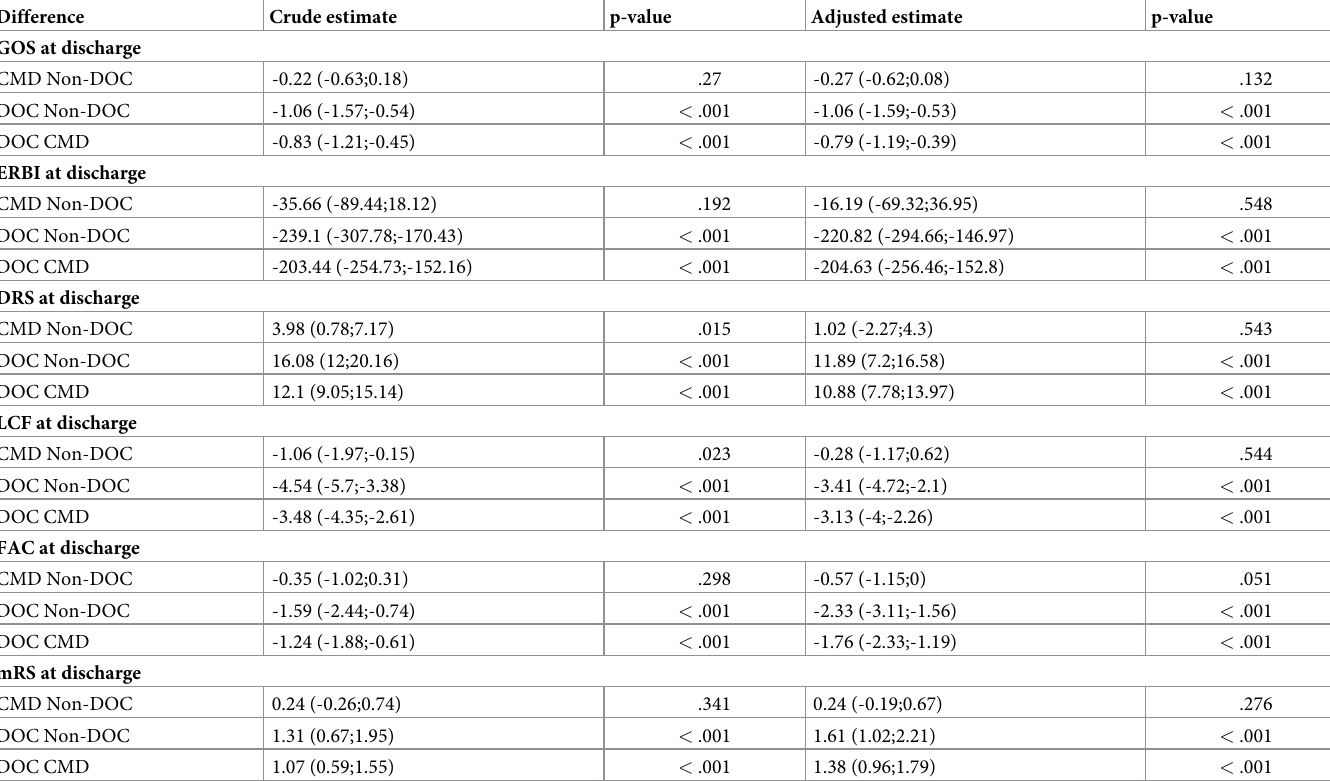
Table 2. Mean differences between the groups for the different response variables measured at the discharge.